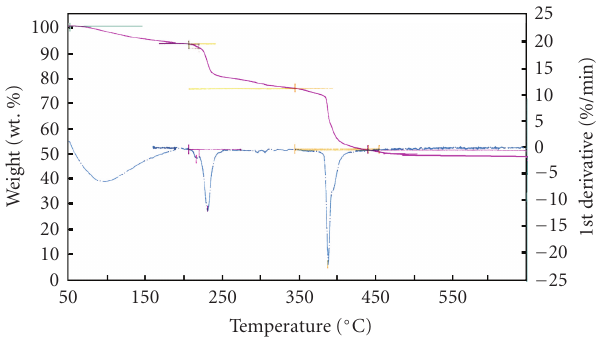
Figure 4: TG and DTG of copper